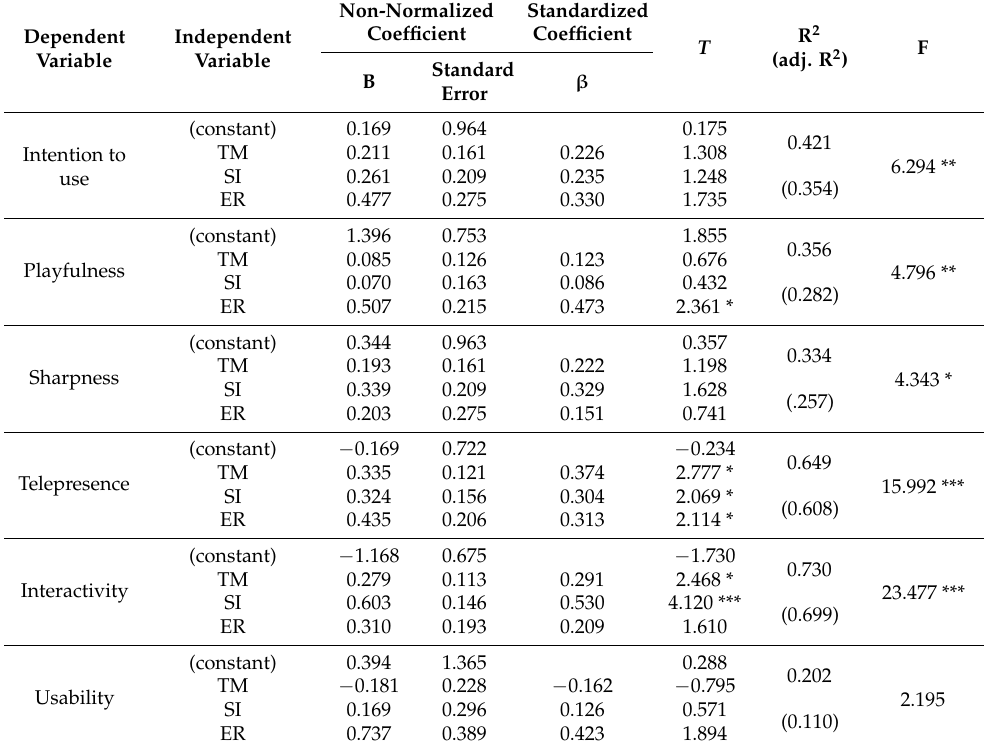
Table 7. Results of multiple regression analysis for immersive VR. * p < 0.5; ** p < 0.05; *** p <